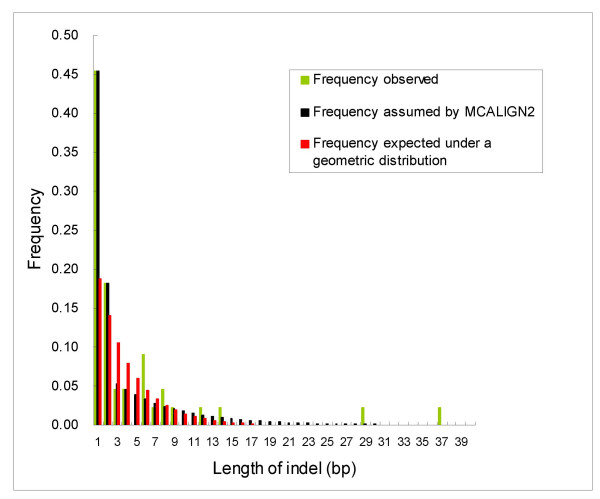
The empirical distribution of indel lengths in noncoding DNA between D. simulans and D. sechellia from Keightley and Johnson 2004 (green histogram), the indel length frequency distribution assumed by MCALIGN2 (black histogram) and the indel length frequency distribution expected under a geometric distribution based on maximum likelihood estimation given the observed data (red histogram).